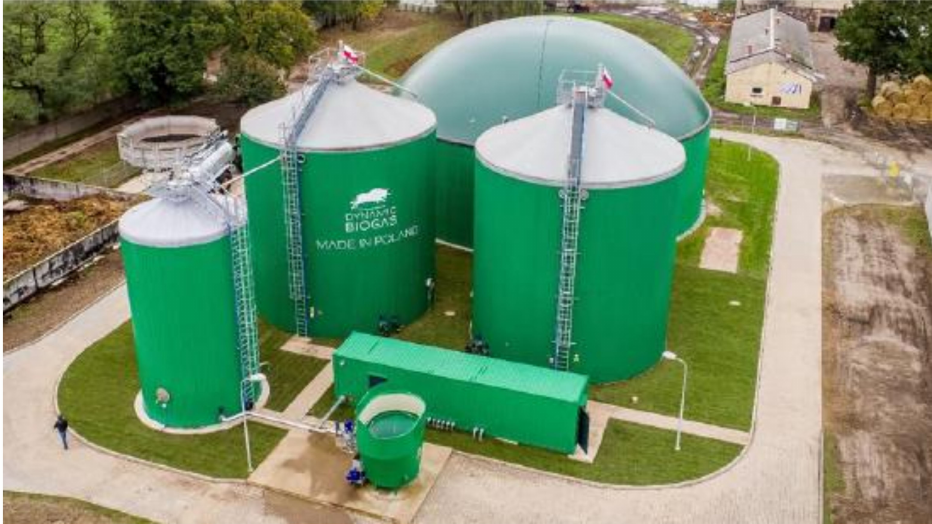
Figure 4. View of the 0.5 MW biogas installation working at Przybroda PULS experimental farm